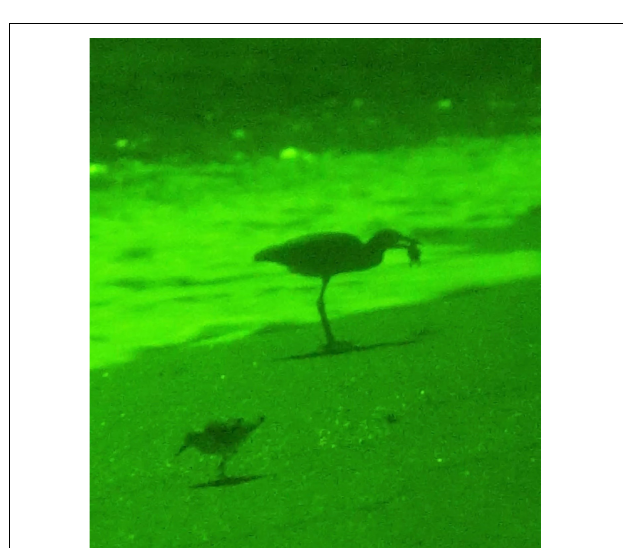
FIGURE 3 | Yellow-crowned night heron ( Nyctanassa violacea ; large bird) preying upon a loggerhead hatchling at Tequesta Beach. Night heron predation was observed directly. The herons pick up, drop, and stab hatchlings with their beaks. In at least one instance, this behavior was repeated for over 15 min before the hatchling was consumed. The smaller bird in the lower left is a sanderling ( Calidris alba ) and is not a hatchling